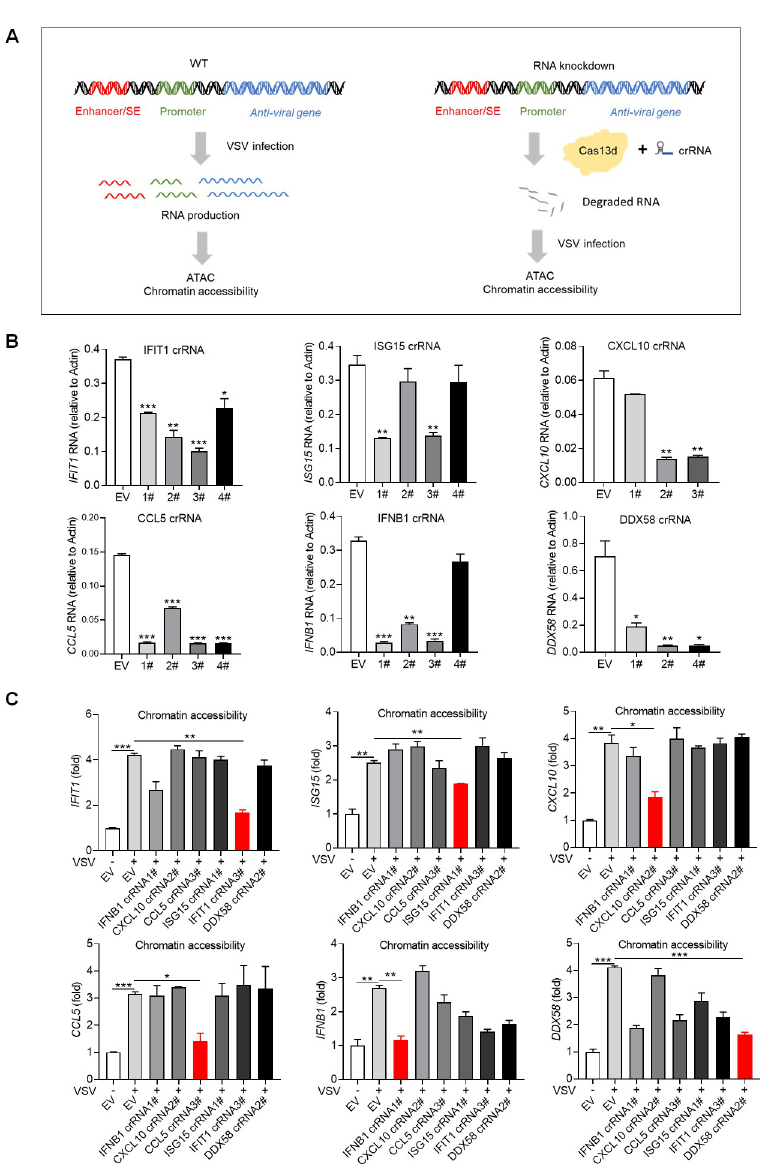
Fig 5. RNA product interacted with SAFA mediated specific chromatin remodeling during viral infection. (A) Models depicting the experiment design of knocking down RNA by CRISPR-Cas13d system and further detecting the chromatin accessibility with ATAC-qPCR after VSV infection. (B) Histogram showing the knockdown efficiency of crRNA of indicated RNAs after VSV infection for 18 hours. (C) ATAC-qPCR results showing the chromatin accessibility of indicated genes after the related RNA knockdown with or without VSV infection for 18 hours. Empty vector (EV) was used as control. � p < 0.05, �� p < 0.01, ��� p < 0.001 (Student’s t test, B and C). The cells were infected by VSV at 0.1 MOI. Data were pooled from three independent experiments (B and C). Error bars, SEM. n = 3